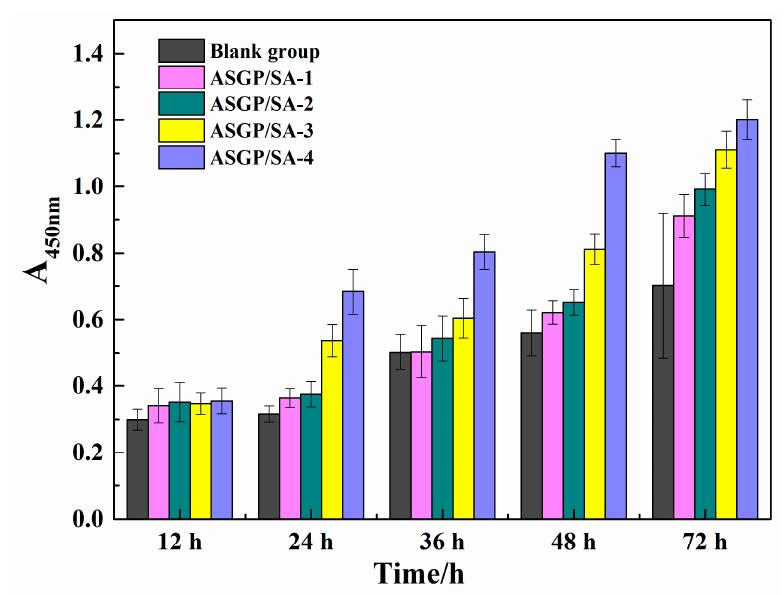
Figure 5. The cytotoxicity of drug loaded hydrogels.